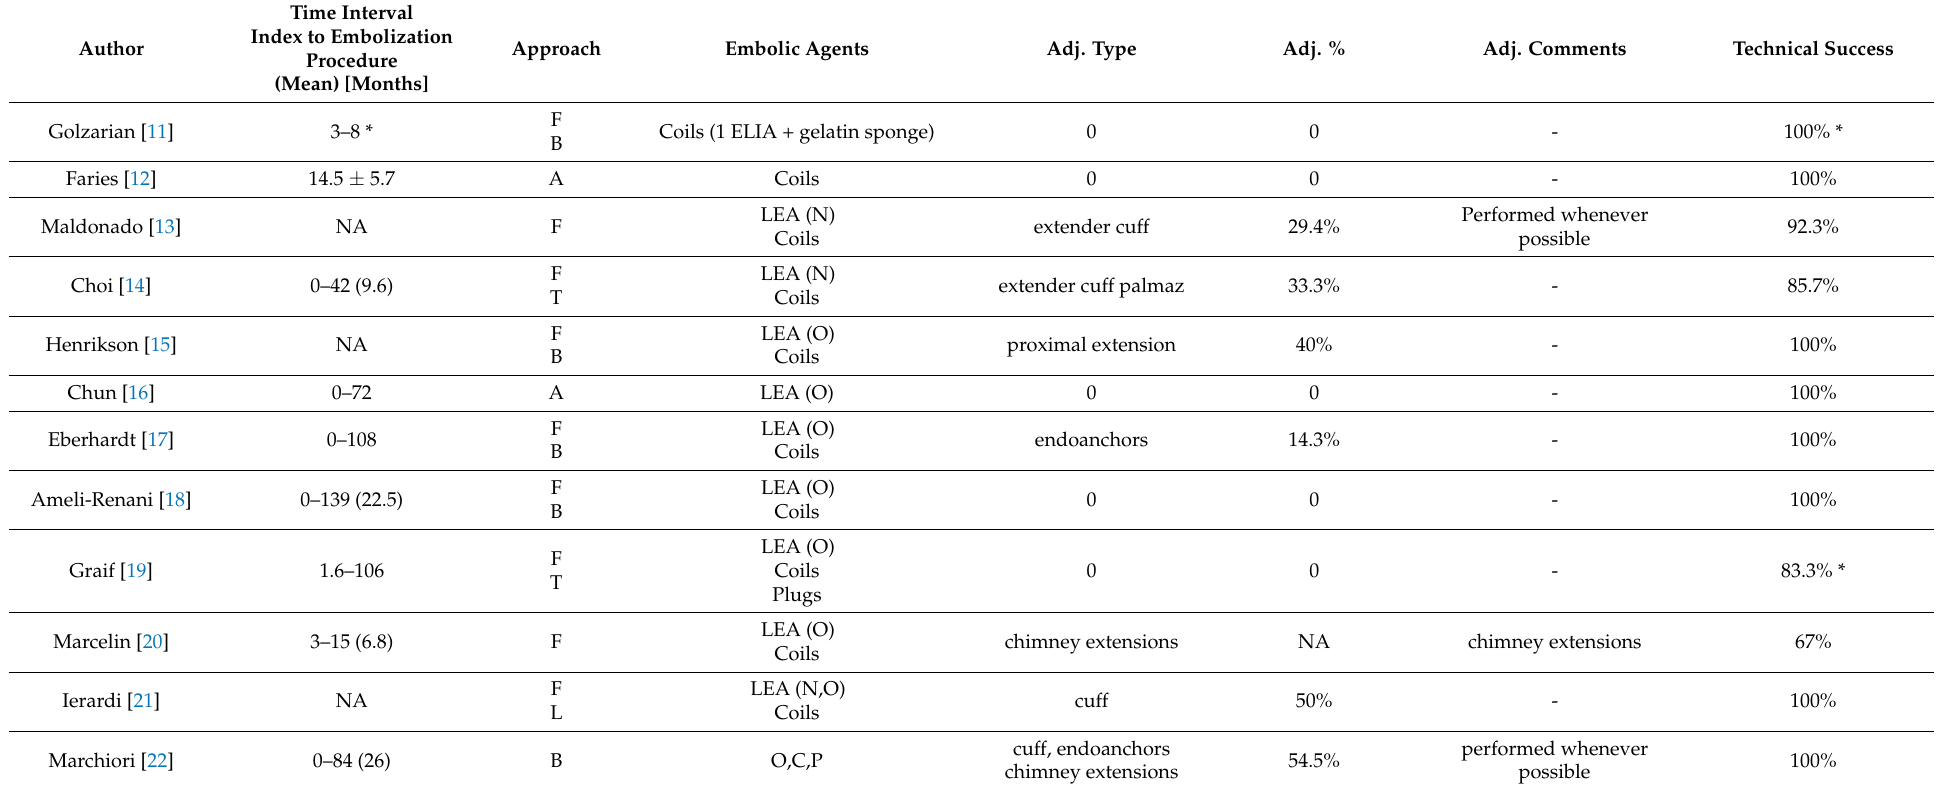
Table 3. Case series: embolization procedure characteristics, materials, approach and technical